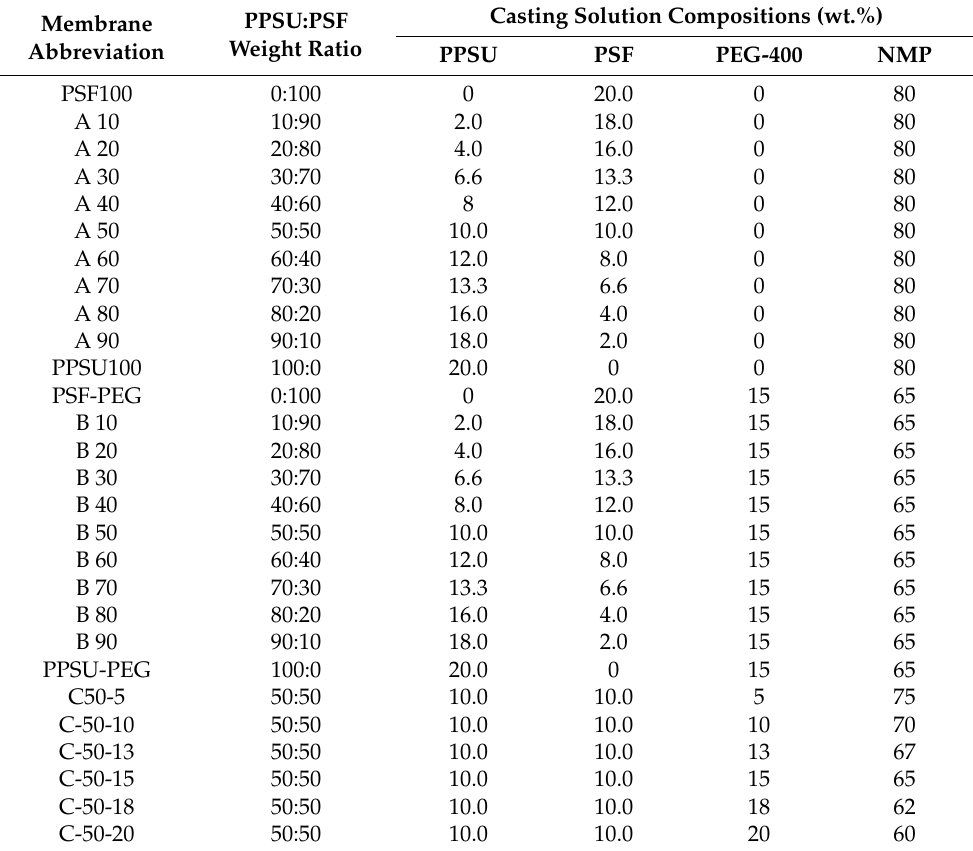
Table 1. Compositions of the casting solution and PPSU/PSF blend membranes